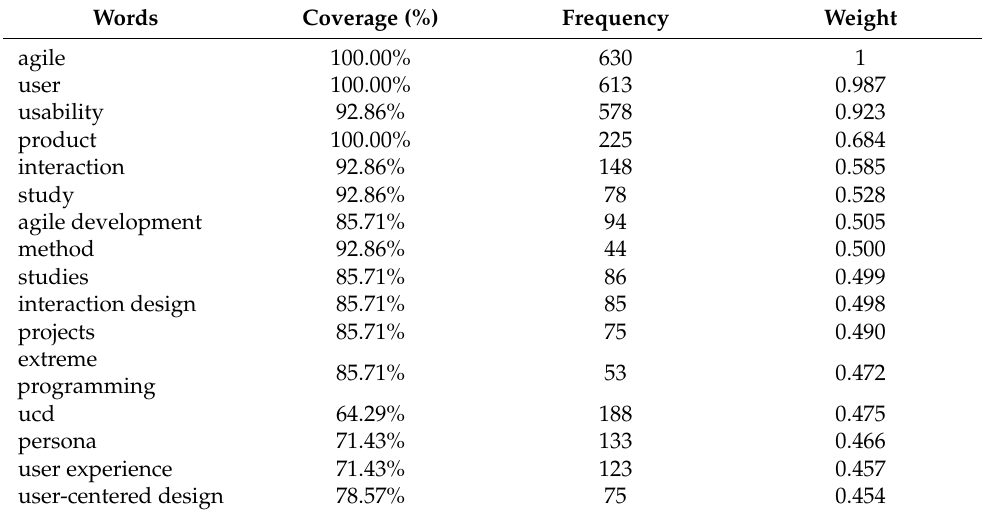
Table A2. Complete list of words obtained from the selection